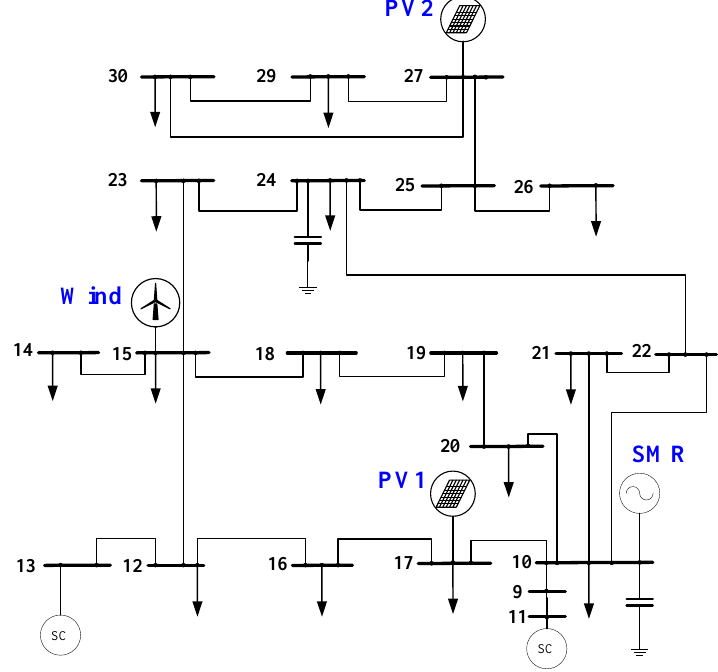
Figure 8. Modified IEEE-30 bus system representing SMR-DER microgrid. The DH system is sized based on the size of electrical system and lumped as a single load. The TES is collocated with the SMR plant along with HXs, as shown in Figure 3. Reference [21] provides the optimum sizing of generation assets based on operational and economic constraints including reactor maneuvering limits, heat waste in DH system, cost of BES, and power system dynamic performance. The sizing of assets is summarized in Table 1. The loads centers in Figure 8 are populated with residential, industrial, and com- mercial load profiles of 15 min resolution obtained from [49]. The heat demand profile is obtained by scaling practical heat load profile from [50] with 15 min resolution. The wind and PV generation profiles are obtained from [51–53],